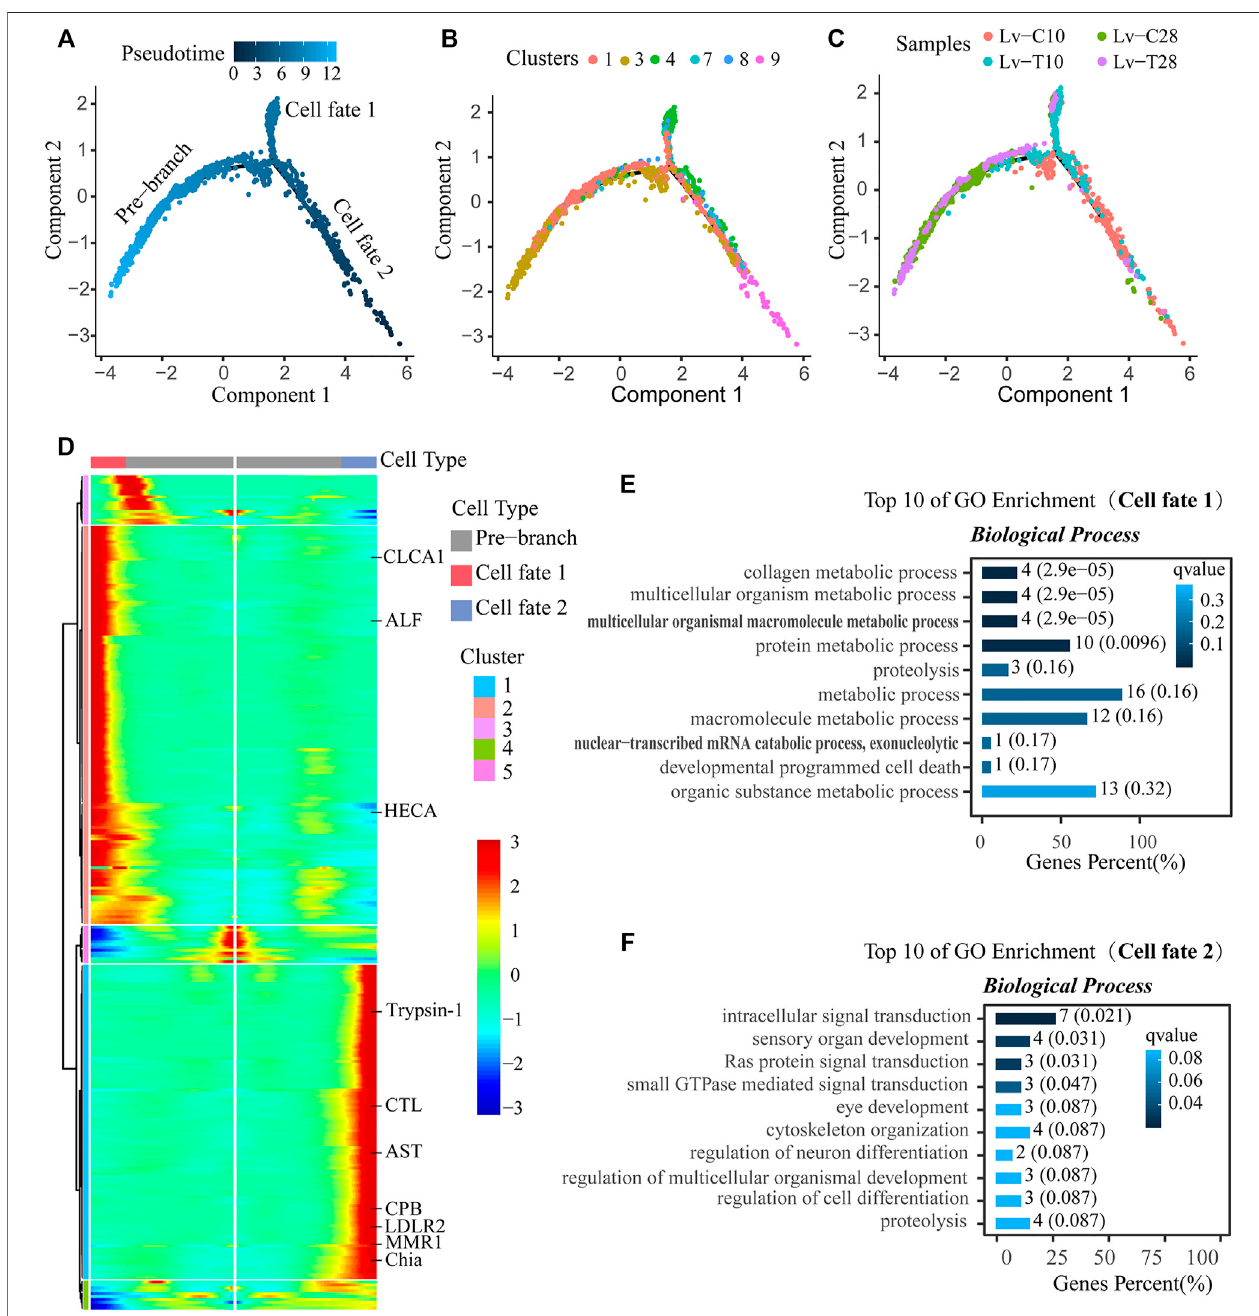
FIGURE 5 | Reconstruction of the differentiation trajectory of F-cells in a quasi-chronological analysis. (A – C) Differentiation trajectory of F-cells with different mappings: (A) pseudotime, (B) cell clusters, and (C) treatment groups. Three cell trajectories are shown in these graphs: the pre-branch, cell fate 1, and cell fate 2. (D) Heatmap showing simulated gene expression dynamics in F-cells during cell state transitions from the pre-branch to cell fate 1 or 2. Pseudotime is shown on the x -axis (with the origin at the center of the axis), and genes are graphed along the y -axis. Gene sets with similar expression patterns are clustered. (E,F) The top 10 GO termswiththesmallestQvaluewereusedformapping.GOtermsareshownonthe y -axis;thepercentagesofthenumberofGOtermstothetotalnumberofdifferences are shown on the x -axis (the darker the color, the smaller the Q value). The digitals on the columns are the GO term numbers and Q values. E is the branch of cell fate 1, and F is the branch of cell fate